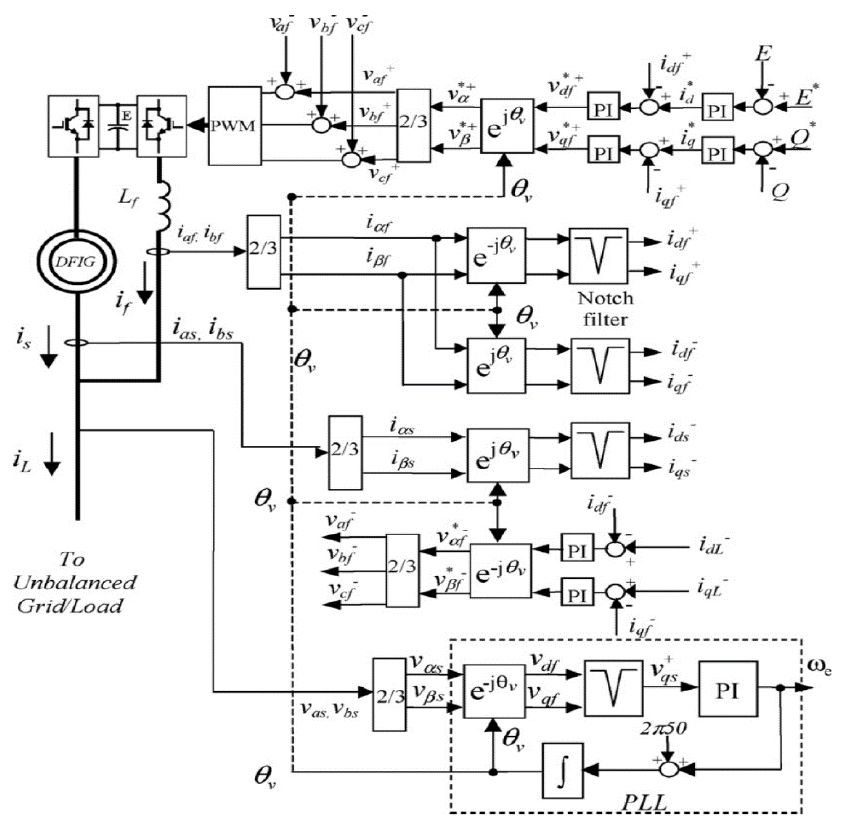
Figure 19. Stator side converter using vector control technique [147]. (∗ ) Demanded value .